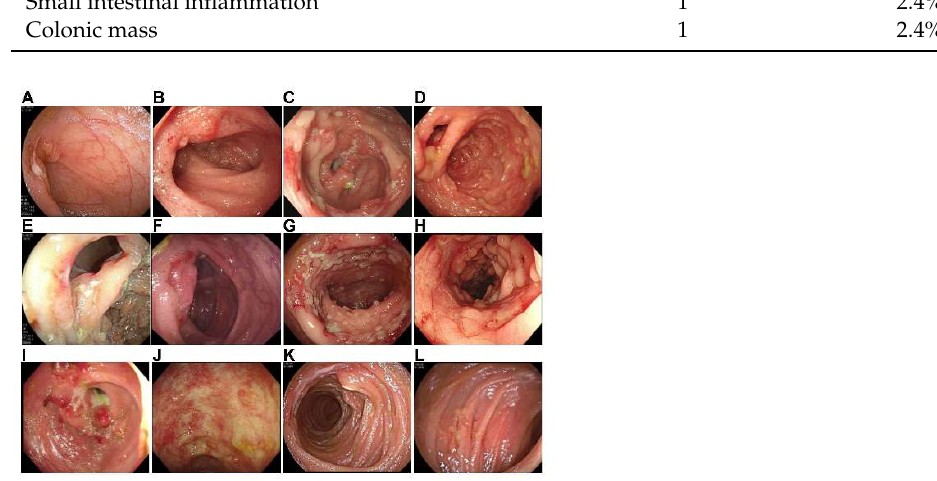
Figure 1. Endoscopic images of patients with ITB. ( A ) Ulcer in the terminal ileal; ( B ) inflammation and erosion in the terminal ileal; ( C ) ulcer in the ileocecal region; ( D ) inflammation and erosion in the ileocecal region; ( E ) ileocecal valve deformation; ( F ) inflammation and erosion in the ileocecal valve; ( G ) pseudopolyps and colonic ulcer; ( H ) colonic inflammation; ( I ) colonic stricture and colonic mass; ( J ) colonic scar; ( K ) jejunal ulcer; and ( L ) small intestinal